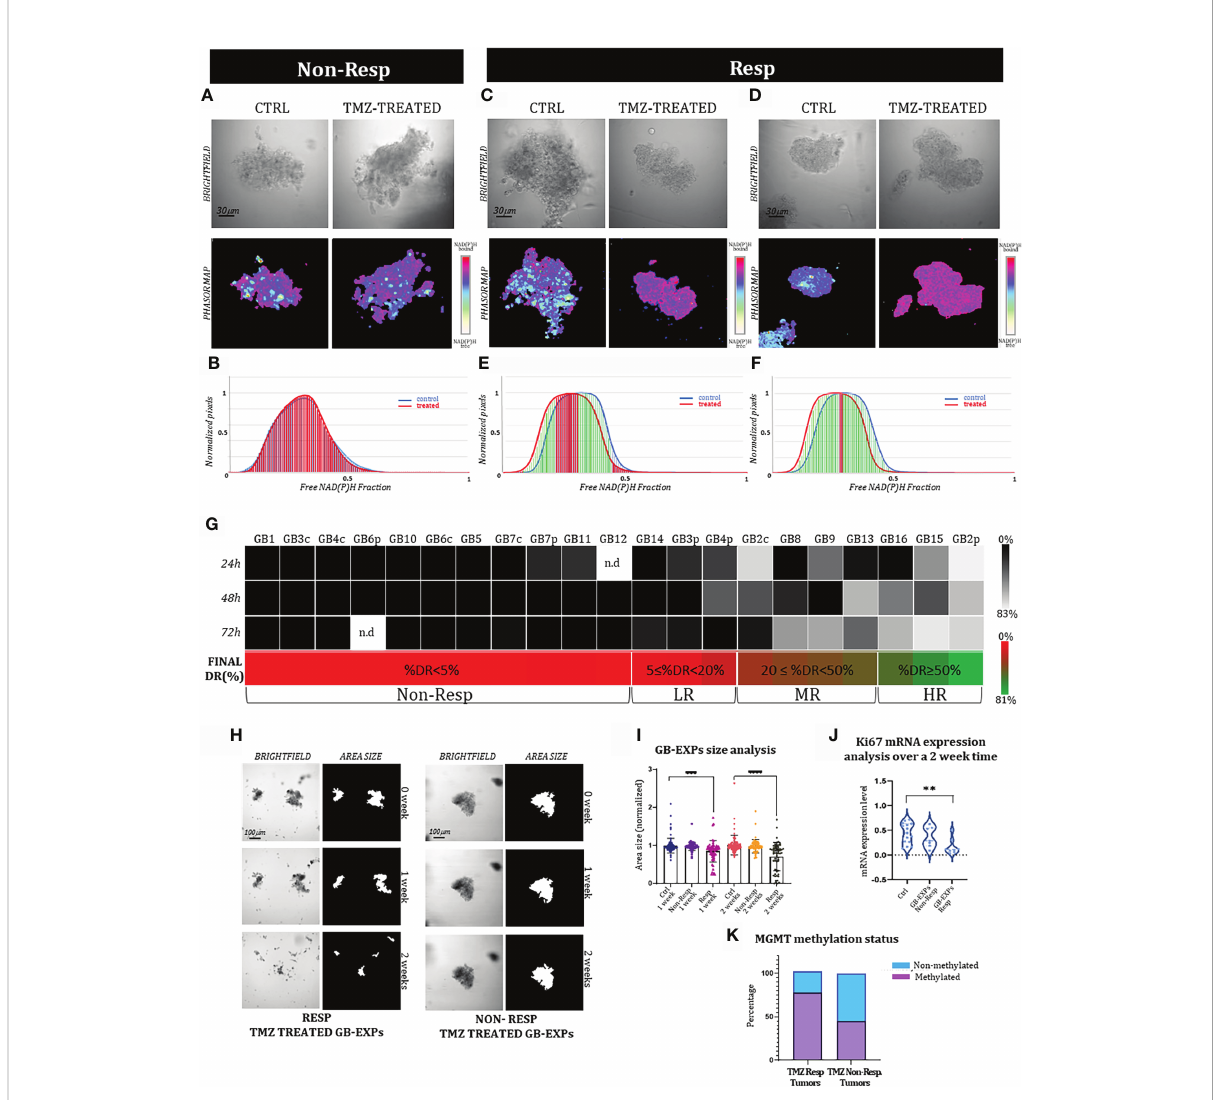
FIGURE 4 FLIM-based metabolic imaging on GB-EXPs. (A, C, D) 72 hr post-treatment one Non-Resp and two Resp tumor derived GB-EXPs are shown including a bright fi eld image and the corresponding phasor map. (B) In the Non-Resp case (A) NAD(P)H fractional mean distribution curves (72hrs) overlap between control (blue) and treated GB-EXPs (red) (B) . (E, F) NAD (P) H fractional mean distribution curves show a left-bound shift of the red curves (treated GB-EXPs). (G) %DR at 24, 48, and 72 hr, represented by a grey scale is shown for each GB case. The annotation of Resp and Non-Resp was assigned on the basis of the Final %DR, obtained from the weighted average of the 3 time points (shown with a green- red color bar for each GB case). Samples are further subdivided based on Final %DR into several categories. (H) Representative bright fi eld and area size images of a Resp and of a Non-Resp case-derived GB-EXP in matrigel at 0, 1 and 2 weeks. (I) Size analysis of Controls, Resp and Non- Resp patients-derived GB-EXPs (n=215, n=130, n=124 respectively) at 1 and 2 weeks. A statistically signi fi cant decrease at 1 and 2 weeks (p=0.0002; p<0.0001, respectively; Student ’ s t test) is shown for the Resp group. (J) Ki67 mRNA expression using ddPCR in Resp (n=8) and Non Resp (n=7) cases after 2 weeks of TMZ treatment (*p=0.003, Student ’ s t test). (K) MGMT promoter methylation status in Resp (n=9) and Non Resp (n=11) cases. Asterisks indicate level of statistical signi fi